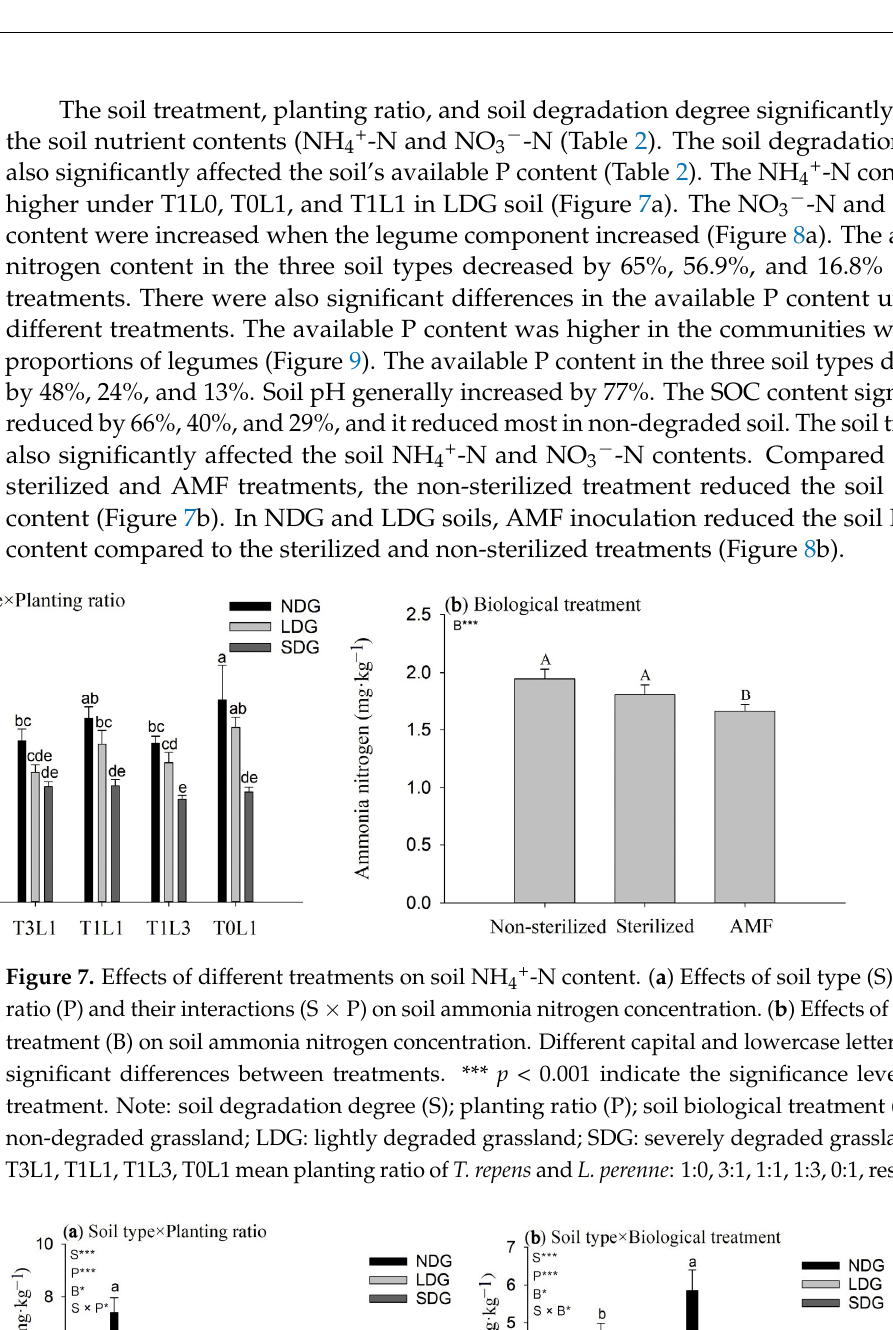
Figure 9. Effects of different treatments on soil available phosphorus content. Effects of soil type (S), planting ratio (P) and their interactions (S × P) on soil available P concentration. Different letters